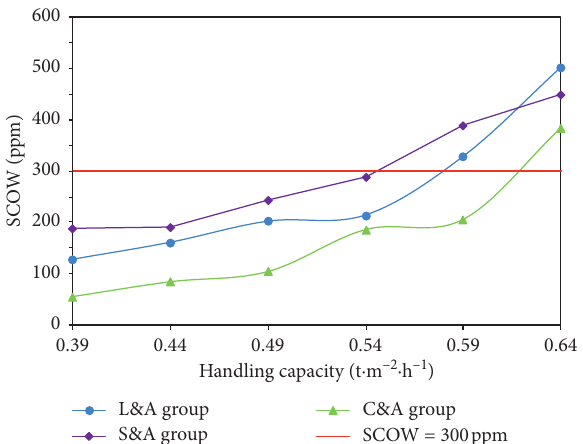
Figure 9: Variation of SCOW with varying handling capacity under the different reagent combinations.